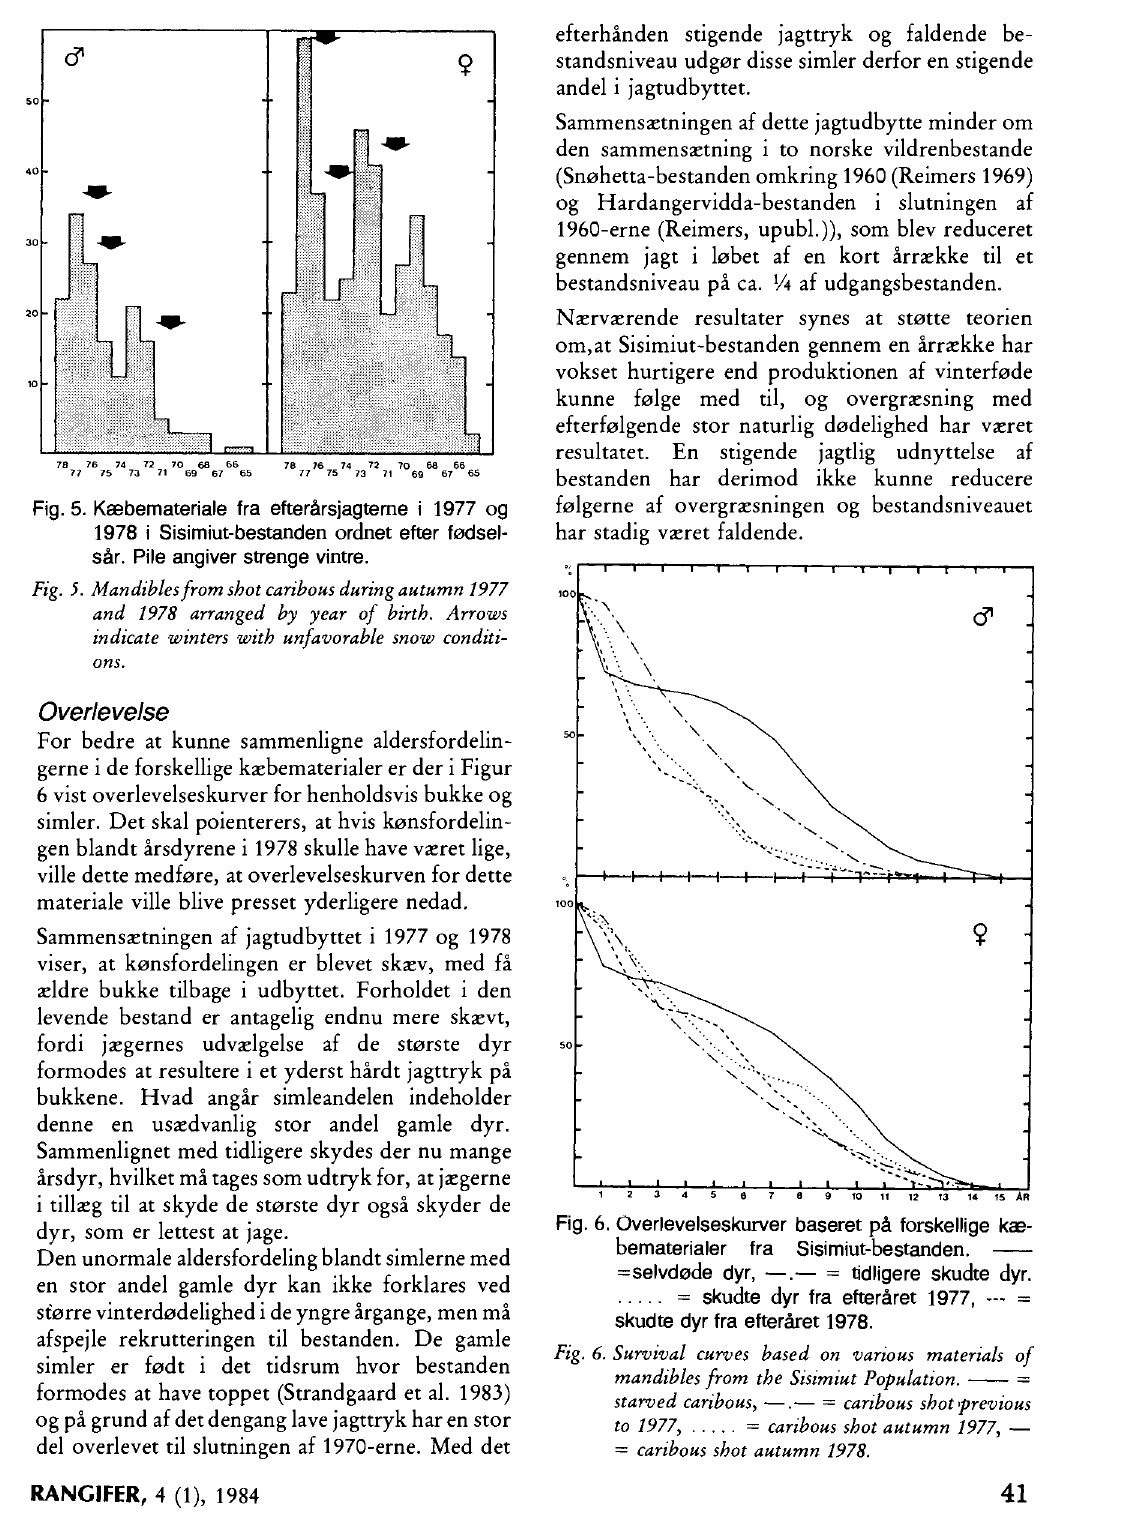
Fig. 6. Overlevelseskurver baseret pa forskellige kae- bematerialer fra Sisimiut-bestanden. =selvdode dyr, — .— = tidligere skudte dyr.